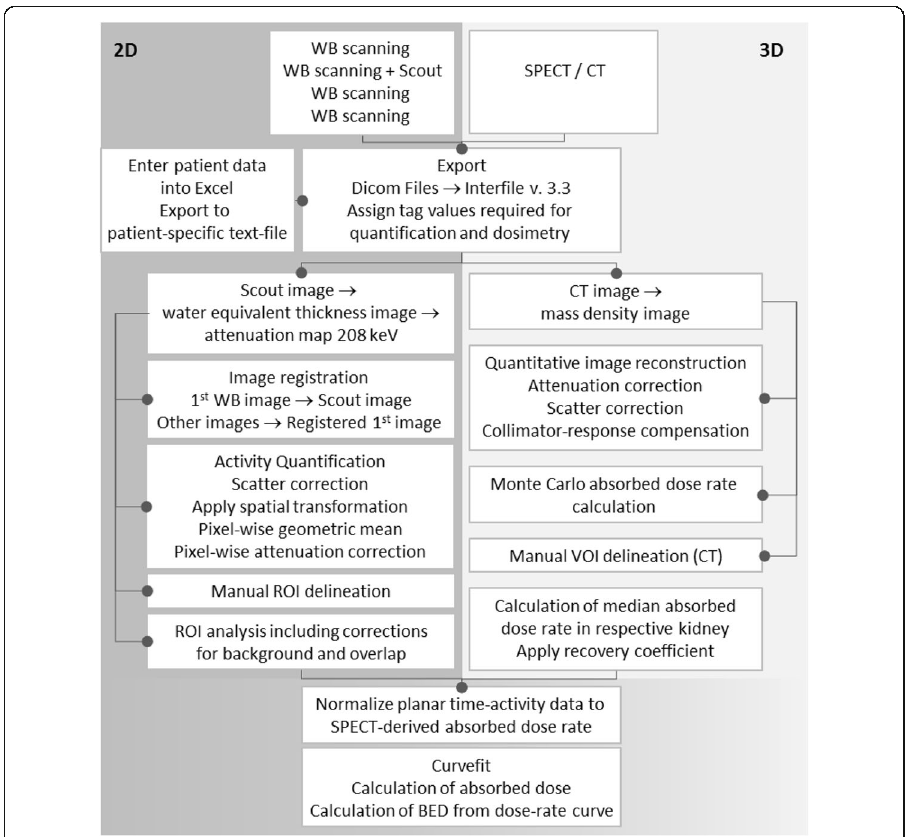
Fig. 1 Schematic representation of the dosimetric method, implemented as part of LundADose and used per protocol (Iluminet